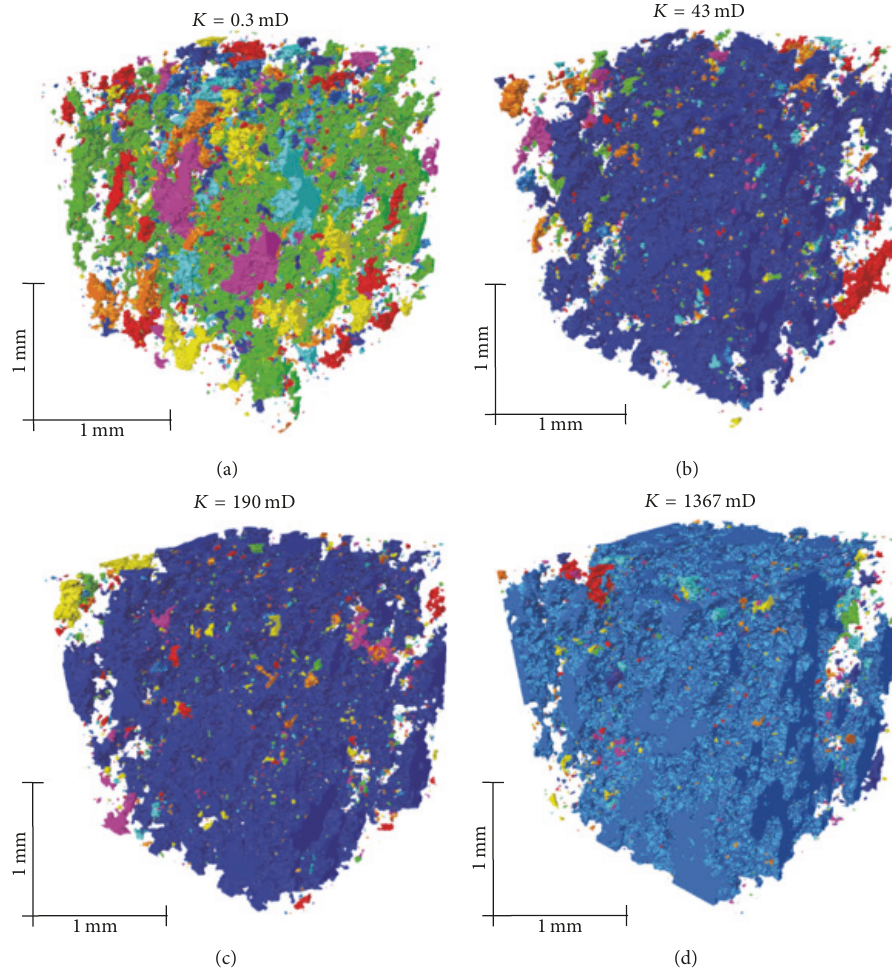
Figure 16: Computer-generated models of a reed facies sample with different 𝜎 values, which controls the level of conditioning data used. (a) Noconditioningdata;(b) 𝜎 =0.75;(c) 𝜎 =0.50;and(d)thelargestamountofconditioningdatawith 𝜎